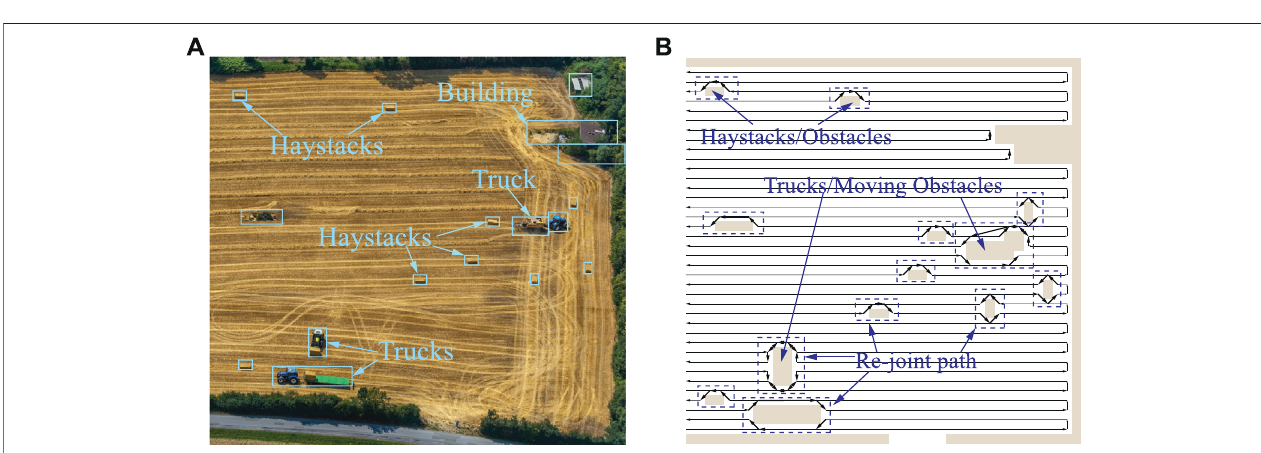
FIGURE 11 | (A) Real-world images taken from UAVs. (B) Re-joint and collision-free CCPP trajectories.